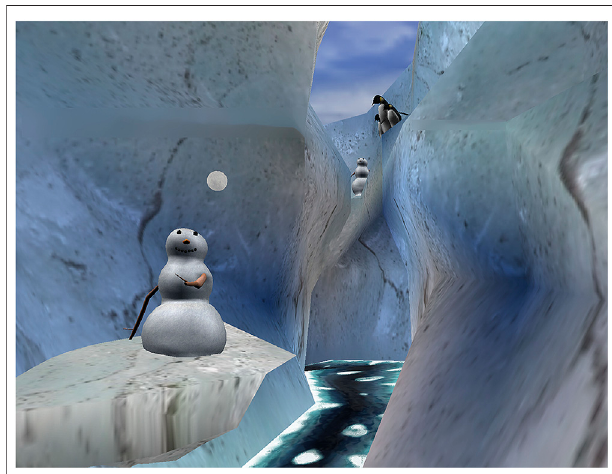
FIGURE1 | Astill shot of what patients see during burn wound care and physical therapy. SnowWorld is the fi rst virtual world custom designed for pain control. Image by Ari Hollander and Howard Rose, copyright Hunter Hoffman, www.vrpain.com.